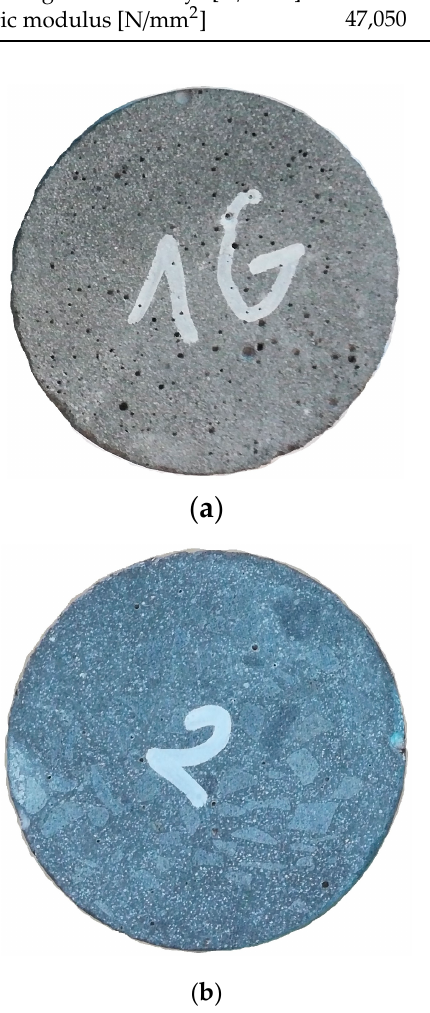
Figure 1. ( a ) Ultra-high performance concrete (UHPC) 1 (max. grain size 1 mm); ( b ) UHPC 2 (max. grain size 8